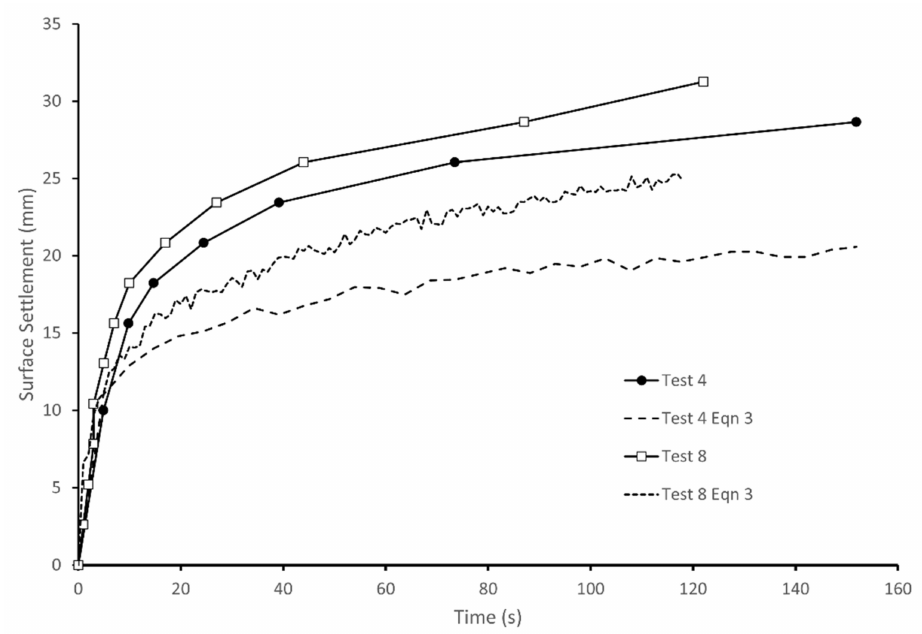
Figure 8. Surface settlements measured in tests 4 and 8 and estimated from changes in